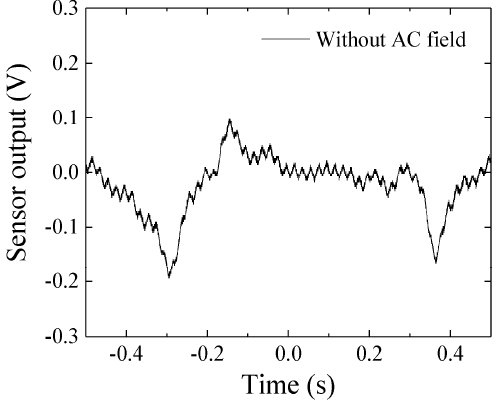
Figure 16. Measured time-domain noise of the sensor system.